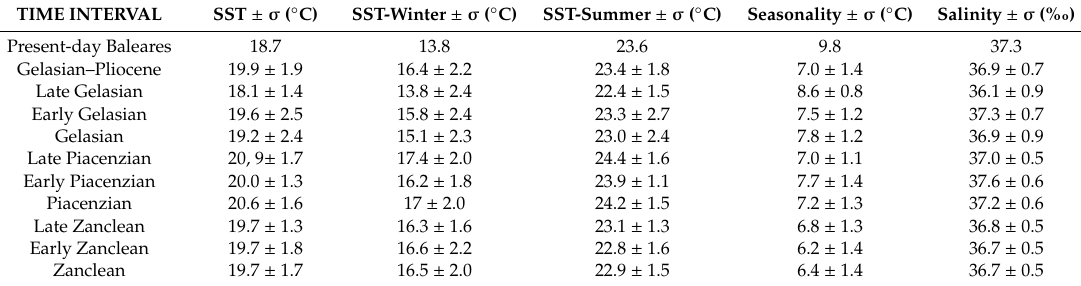
Table 3. Mean values of the oceanographic parameters for the di ff erent time intervals. TIME INTERVAL SST ± σ ( ◦ C) SST-Winter ± σ ( ◦ C) SST-Summer ± σ ( ◦ C) Present-day Baleares